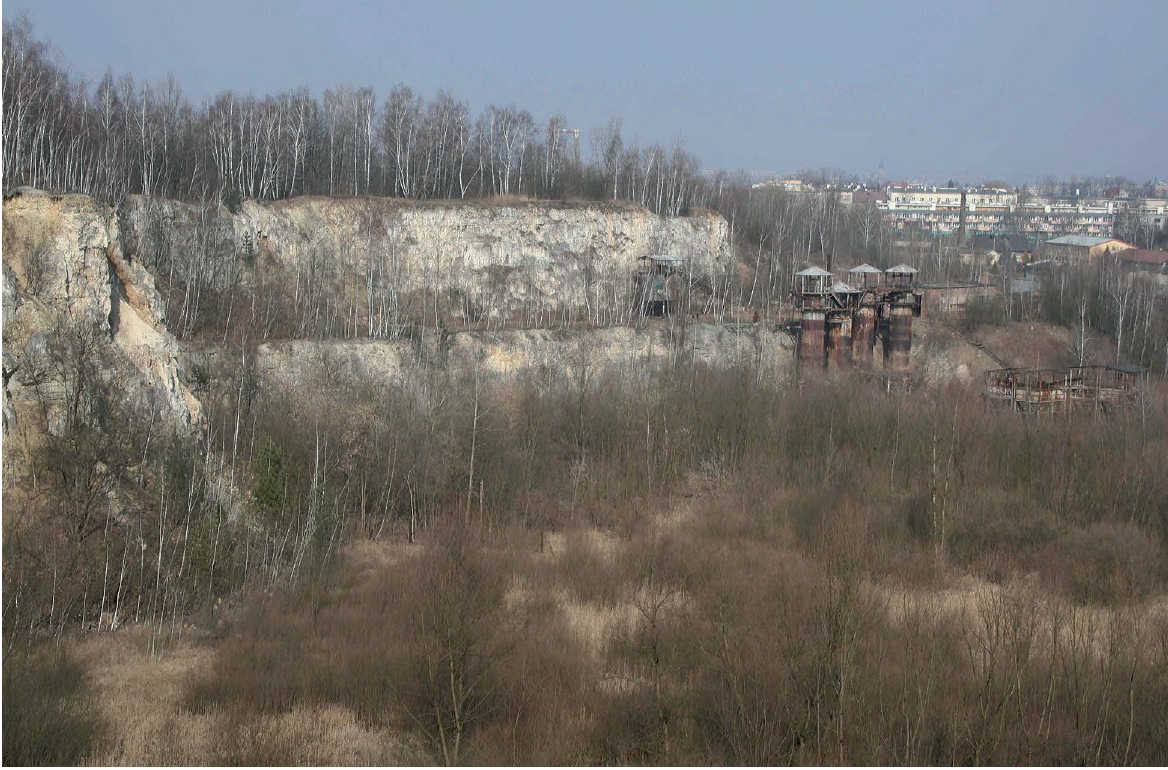
Fig. 6. Landscape in a renaturalisation process in the area in the North aspect of “Liban”